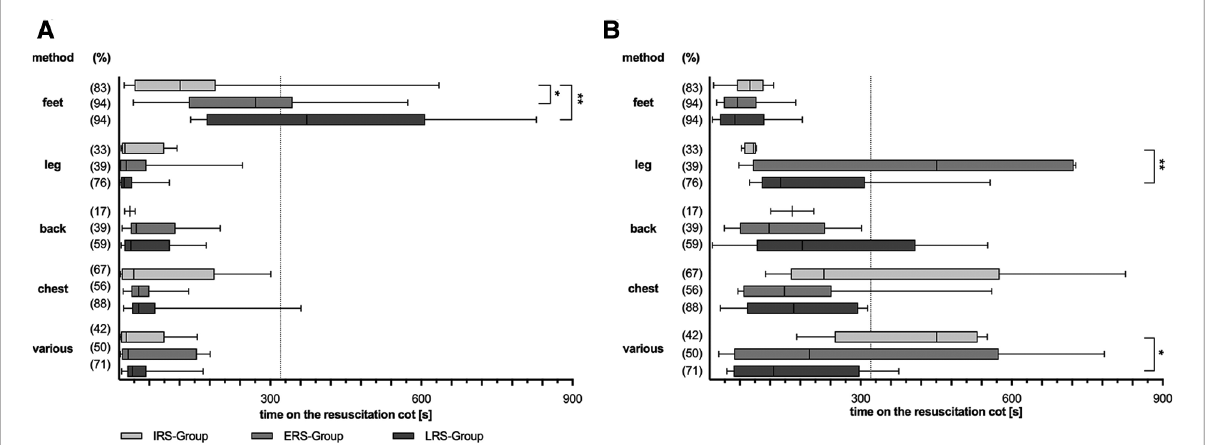
FIGURE 3 Stimulation procedure divided by different stimulation methods. Overall duration ( A ) and fi rst time ( B ) of different tactile stimulation (TS) methods during the fi rst 15 min of postnatal support. Three subgroups are depicted: LRS, late respiratory stability group; ERS, early respiratory stability group; IRS, immediately respiratory stability group. (%) – proportion of stimulated infants within the particular group; p -values – ( A ) ** p =0.005, * p =0.024; ( B ) ** p =0.009, * p =0.015. Various stimulation method – de fi ned as stimulation not assignable to one of the other methods.